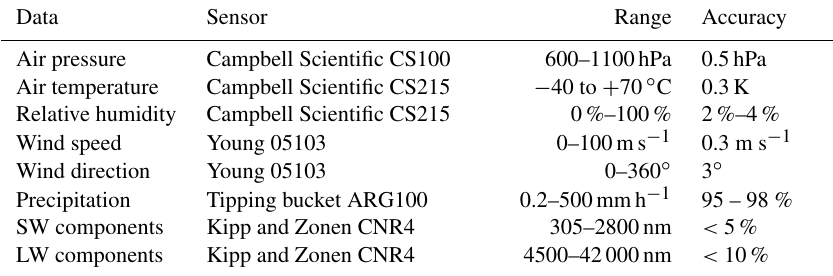
Figure 2. Automatic weather station on Lake Kivu after its installation, 8 October 2012 (© Wim Thiery). Position (a) indicates the location of the temperature, relative humidity and radiation sensors at 4.40m above the lake surface. Position (b) shows the location of the wind vane at 7.20m above the lake surface. Position (c) indicates the container on which the station was mounted. Table 1. AWS Kivu sensor